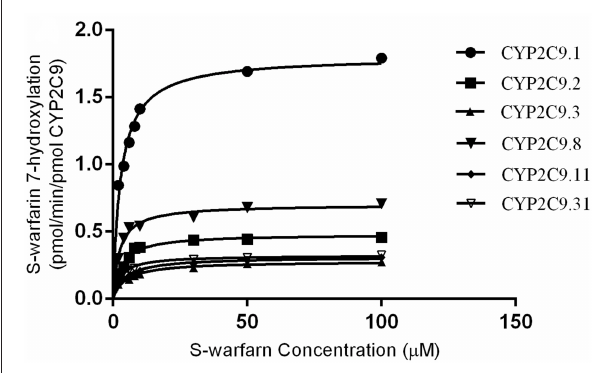
FIGURE 2 | Kinetics of S-warfarin 7-hydroxylation by COS-7 cell-expressed CYP2C9.1, CYP2C9.2, CYP2C9.3, CYP2C9.8, CYP2C9.11 and CYP2C9.31. Every point represents the mean of three independent experiments.